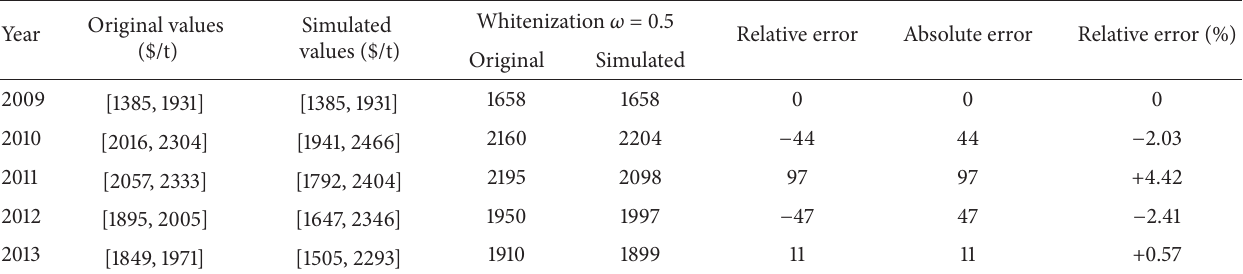
Table 3: Relative and absolute error of the model.